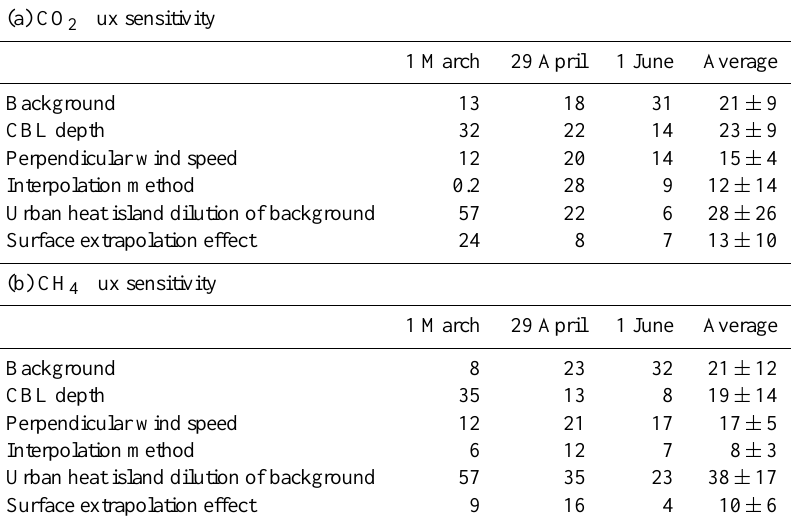
Table 2. Percent change in (a) CO 2 and (b) CH 4 emission rate as a function of the uncertainties in analysis parameters for three Indianapolis flight dates in